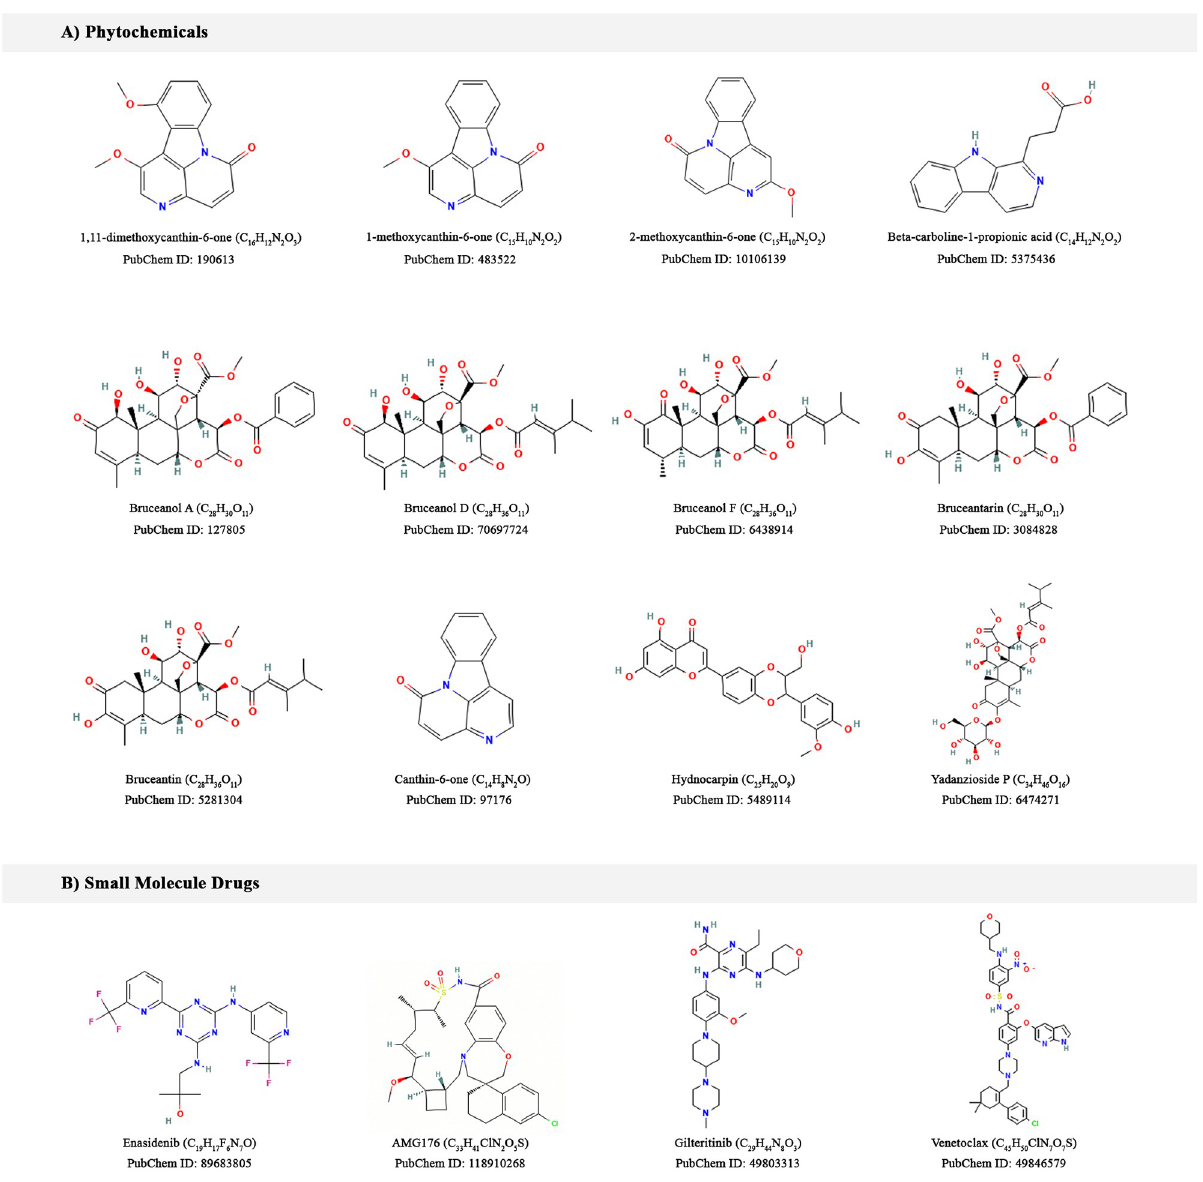
Fig 2. 2D structures of the investigated compounds in this study. (A) Selected B . antidysentrica phytochemicals and (B) Small molecule drugs.